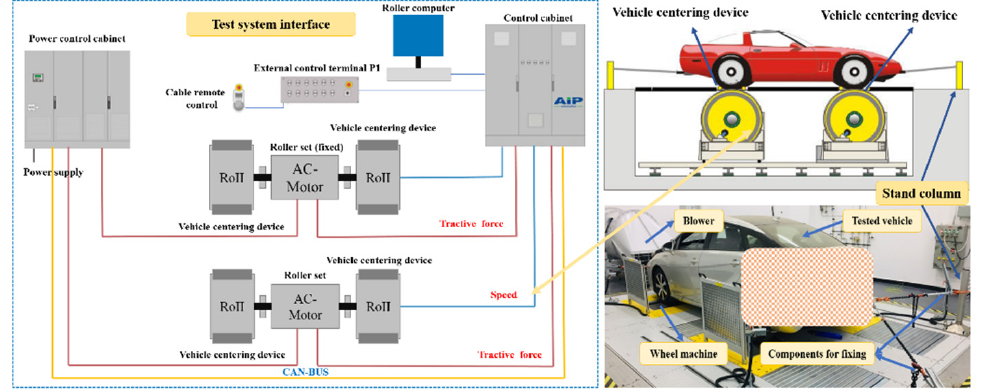
Figure 3. Diagram of the test equipment and interface.